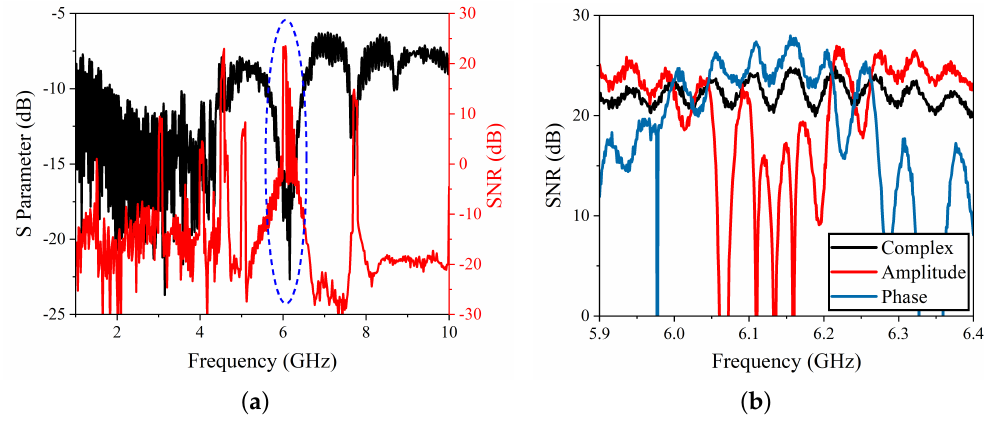
Figure 3. Signal-to-noise ratio of the iSMM microscopy system. ( a ) The S 11 and complex SNR in the frequency range of 1–10 GHz. The SNR peaks around the resonance frequency close to 6 GHz. ( b ) The SNR complex, amplitude, and phase in the chosen frequency band for the iSMM